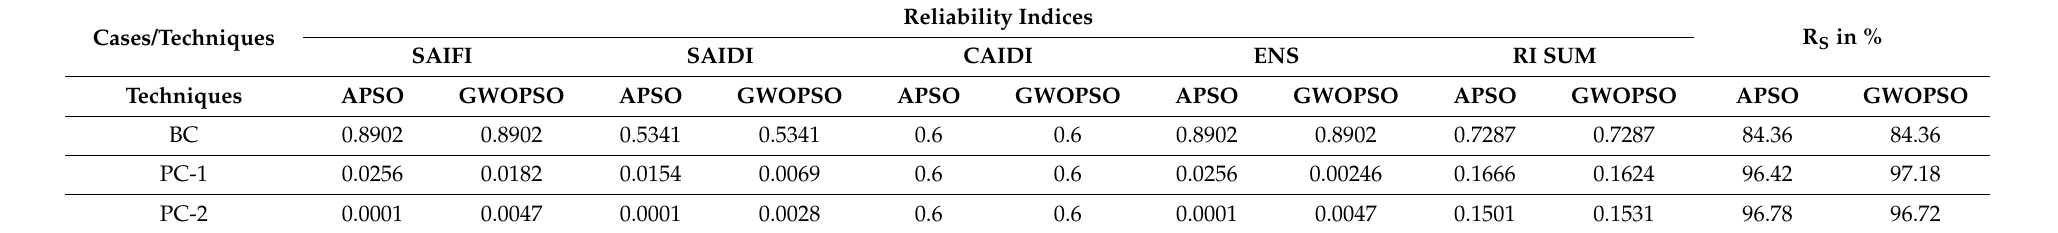
Table 12. Indices of Reliability of the IEEE 69-bus RDN.